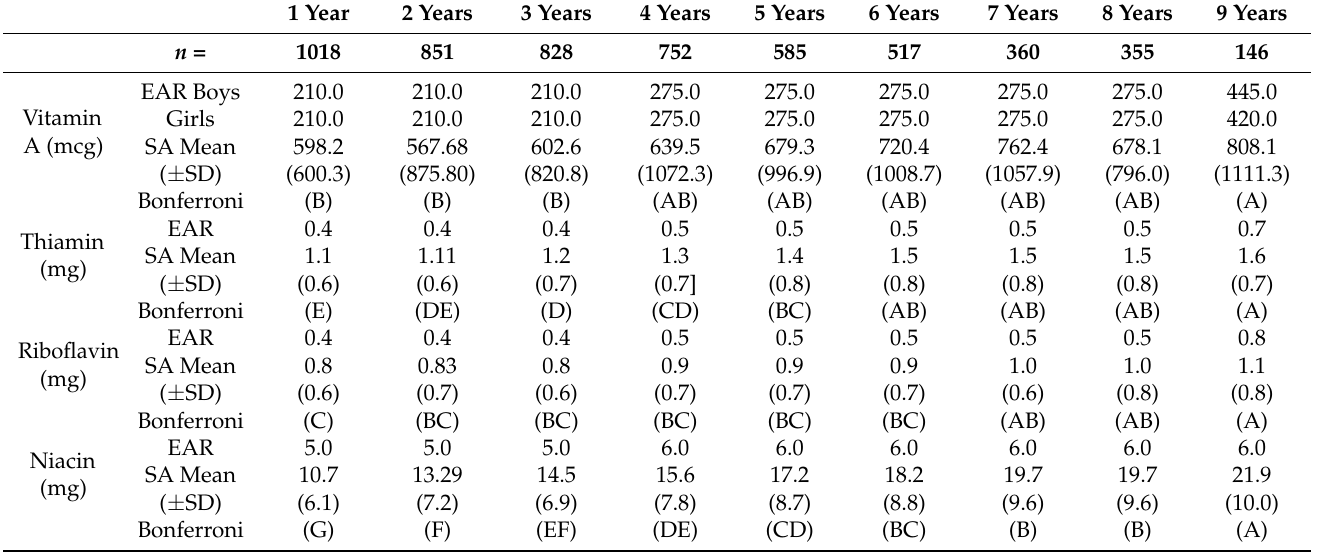
Table 5. South African child mean ± SD intake of vitamins by year of